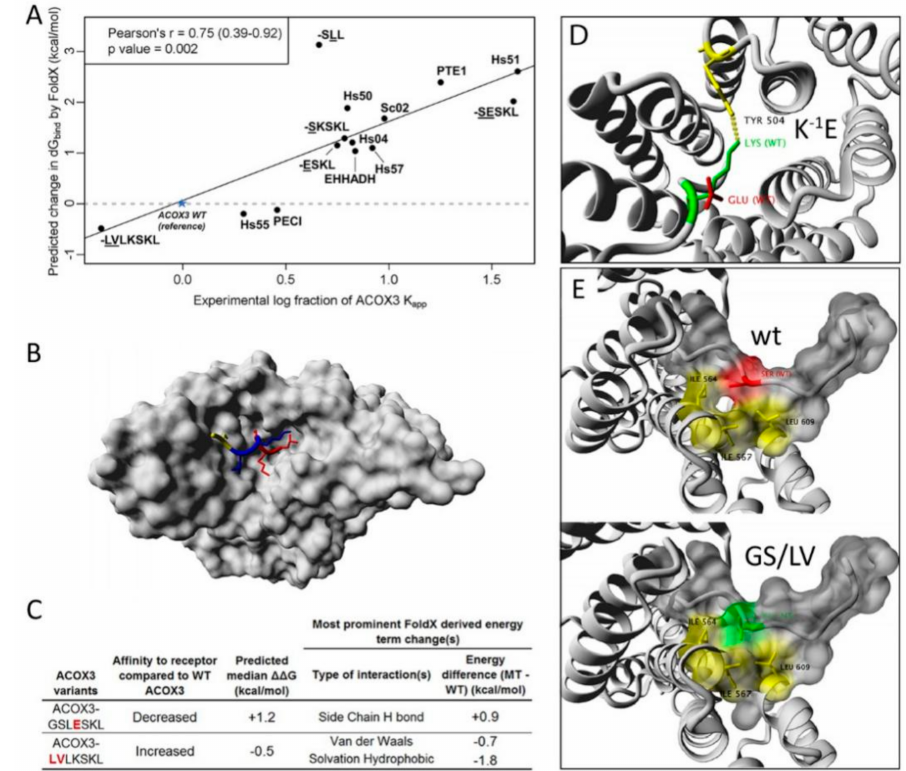
Figure 6. Computational investigation of the interaction between the TPR domain of PEX5 and PTS1 containing peptides: ( A ) The computationally calculated binding strengths between PEX5 TPR and di ff erent PTS1 peptides described in Figures 3A and 5A,H correlates with K aapp values obtained by FlowFRET. The binding strength is predicted by FoldX based on the 3D-structure of human PEX5 TPR bound to a PTS1 [43] and expected di ff erences upon replacing the peptide are calculated, which are expressed as change in the binding energy ∆∆ G relative to a reference peptide (ACOX3). The K aapp s obtained by FlowFRET experiments are depicted as logarithm of the ratio between the K aapp of the reference peptide (ACOX3) and the K aapp of the peptide of interest. Variants of ACOX3 are indicated by the peptide sequence underlining the introduced residues; ( B ) 3D model of PEX5 TPR burying the PTS1 of ACOX3 with the C-terminal tripeptide (red), the residues − 1 and − 2 (blue) and the upstream sequence − 3 and − 4 (yellow); ( C ) prediction of the predominant type of energetic change upon introduction of mutations (red) using FoldX; ( D , E ) putative rearrangement of side chains at the interphase upon introduction of the mutations: the point mutation K -1 E ablates the hydrogen bond to tyrosine (Y504) ( D ), whereas the double mutation -4 GS -3 / LV introduces a hydrophobic surface facilitating an additional hydrophobic interaction with PEX5 (red: serine, green: valine, ( E